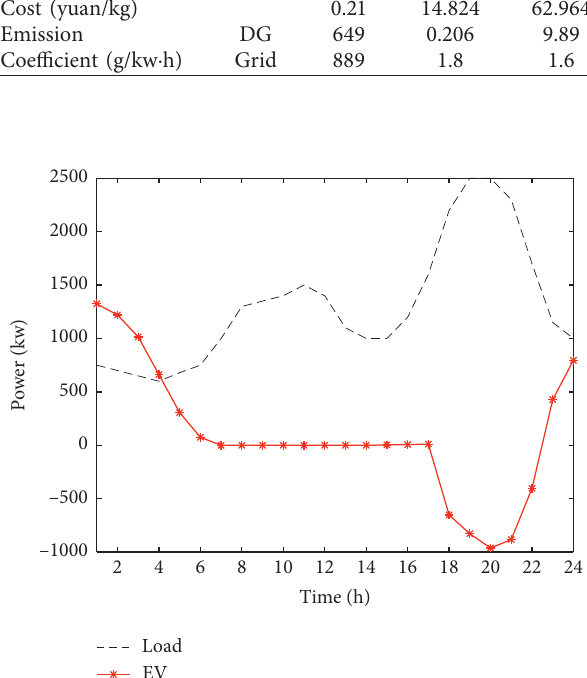
Figure 5: Daily load curve and output of EVs following users’ driving habits.